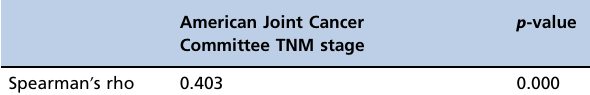
Table 5 - A linear regression analysis of the American Joint Cancer Committee TNM stage and the NLR in patients X 45 years of